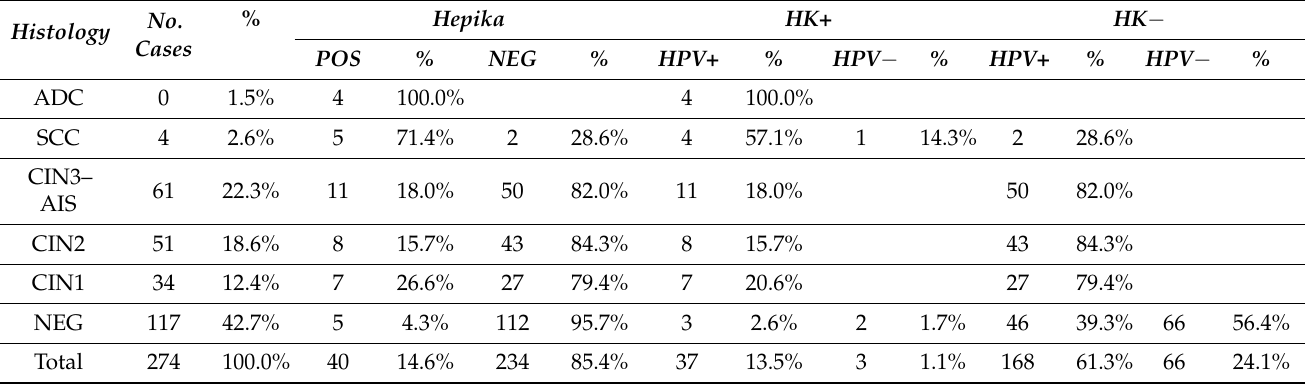
Table 4. Hepika test results based on HPV test and review histology.